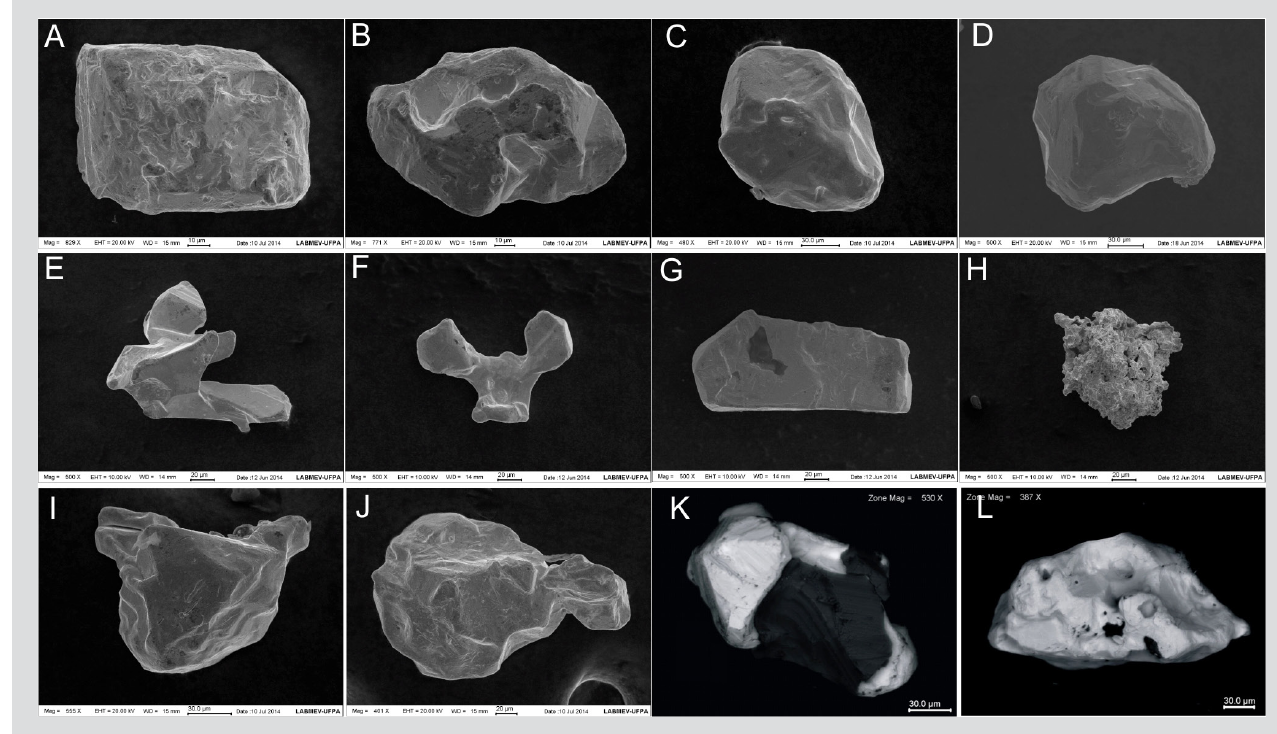
Figure 11 - (A) General view of an old open-pit in metasandstone. (B) Hand samples of metasandstone with gold particles (within circles) hosted in fractures coated with secondary iron oxides.